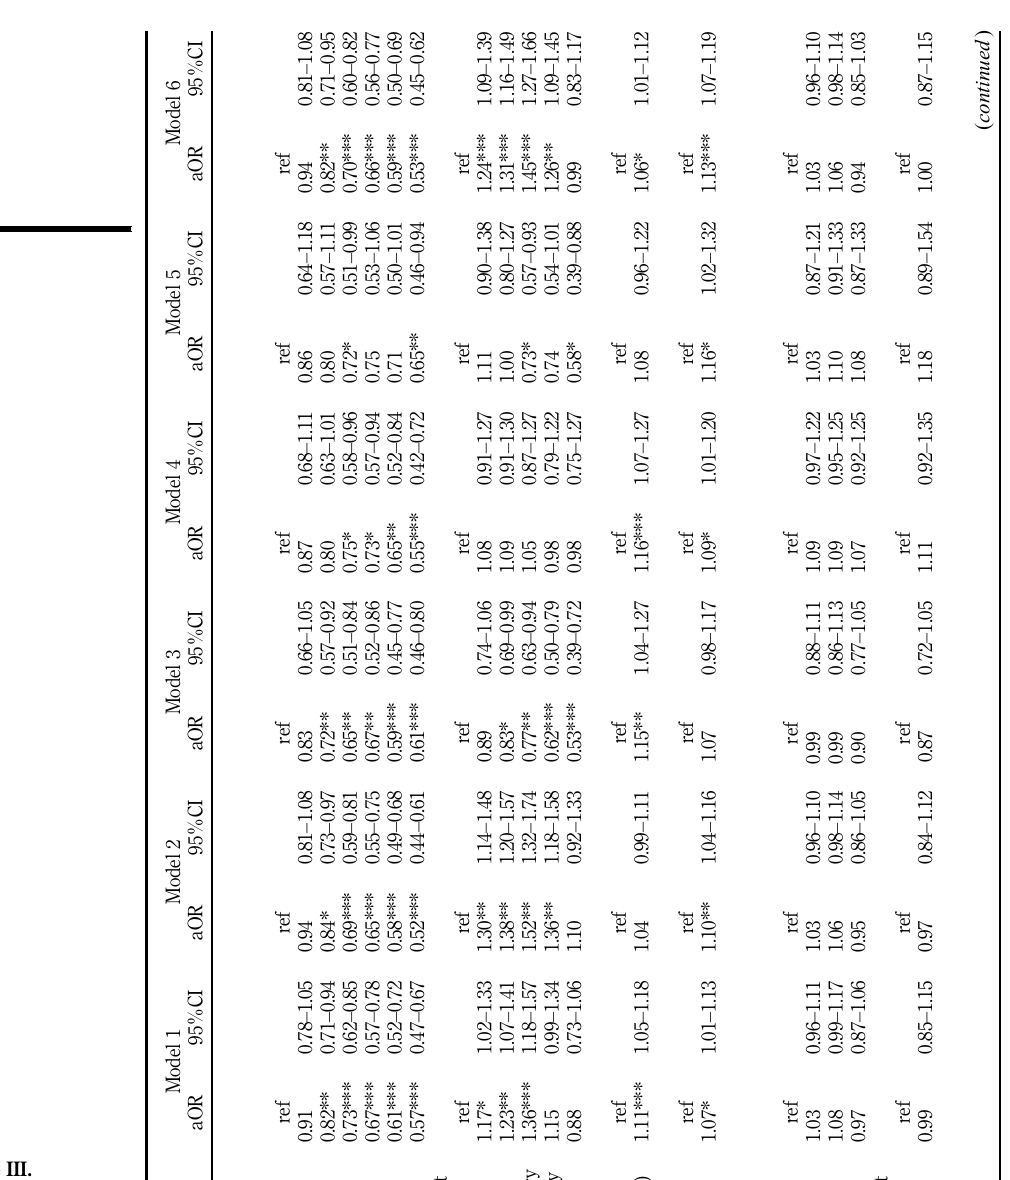
Table III. Multivariate